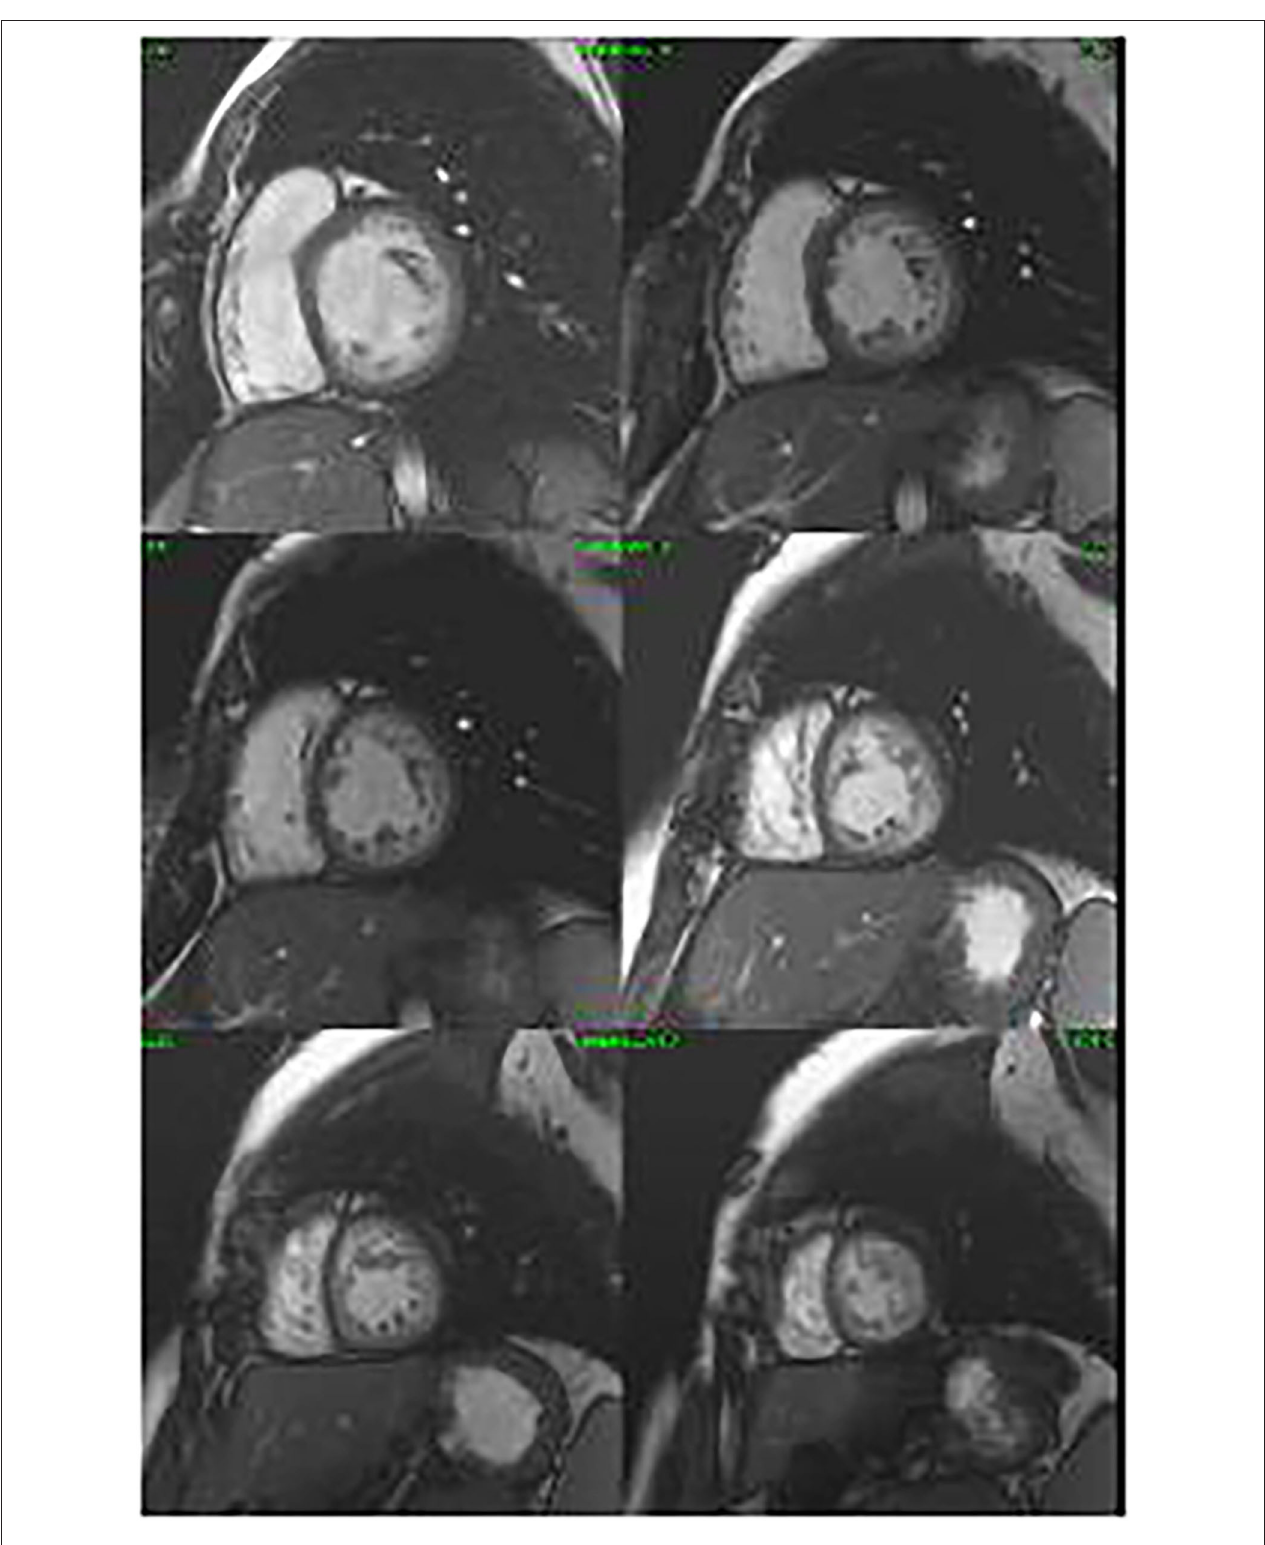
FIGURE 3 | Cine cardiac magnetic resonance images in the short axis revealing non-compaction cardiomyopathy.